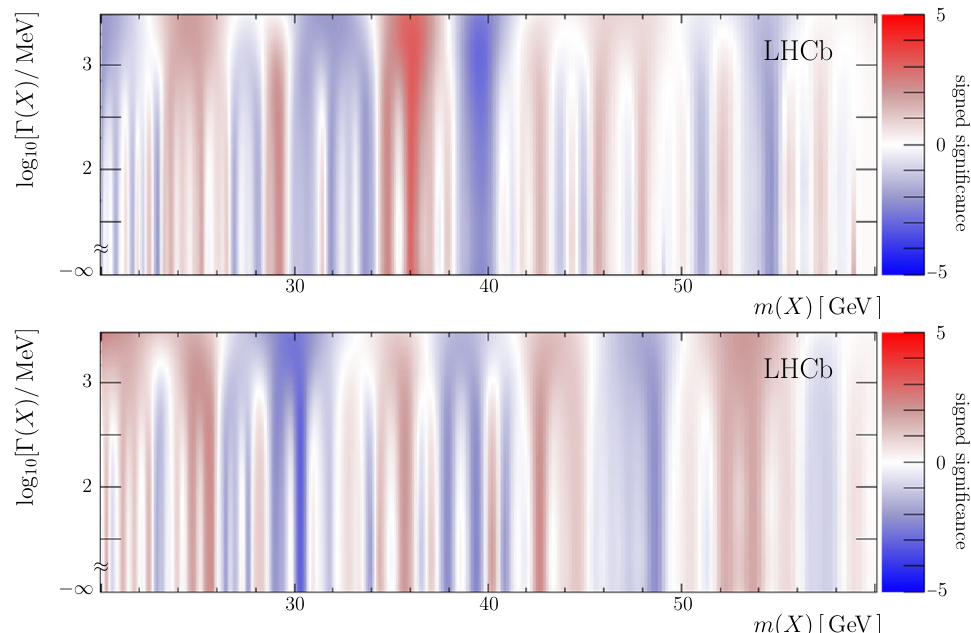
Figure 4 . Signed local signi(cid:12)cances in the m ( X ) > 20 GeV region for the (top) inclusive and (bottom) associated beauty searches for prompt X (cid:22) + (cid:22) (cid:0) decays. The lower limit on the vertical ! axis of log [(cid:0)( X ) = MeV] = corresponds to (cid:0)( X ) = 0. 10 (cid:0)1